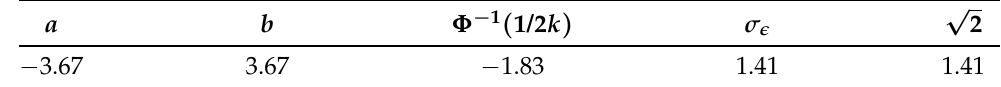
Table 7. Obtained limits of the MKSR in Case 2.